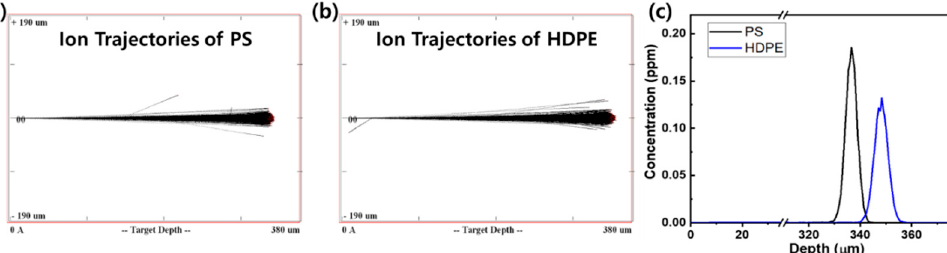
Figure 3. Ion trajectories of a 20 MeV He ion beam irradiated onto ( a ) PS, ( b ) HDPE and ( c ) He ion depth-dependent concentration profile simulated using SRIM code.